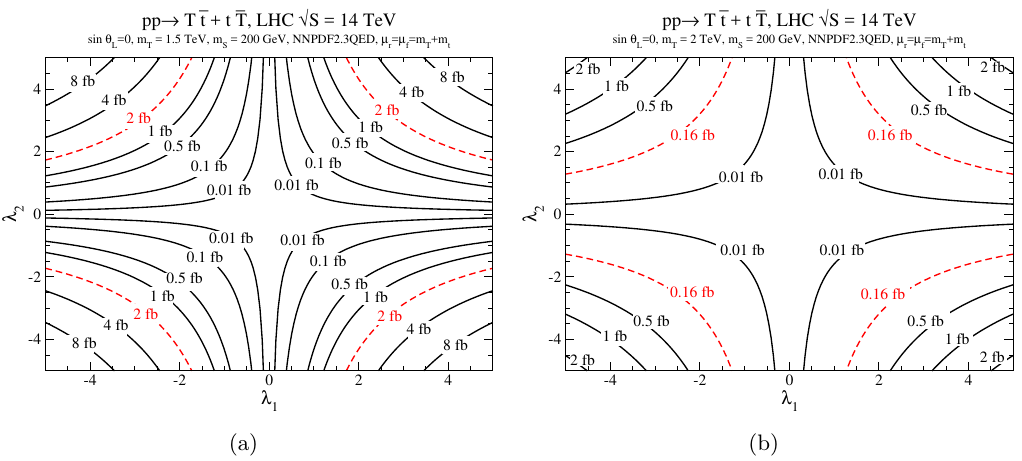
Figure 5 . Contours of production cross sections at the p S = 14 TeV LHC for top partner pro- duction in association with a top quark in the (cid:21) 2 (cid:21) 1 coupling constant plane for top partner (cid:0) masses (a) m T = 1 : 5 TeV and (b) m T = 2 TeV. The red dashed lines indicate the TT production cross section. The other parameters are m S = 200 GeV and sin (cid:18) L = 0. The factorization and renormalization scales are set at (cid:22) r = (cid:22) f = m T + m t for Tt production and (cid:22) r = (cid:22) f = 2 m T for the TT cross